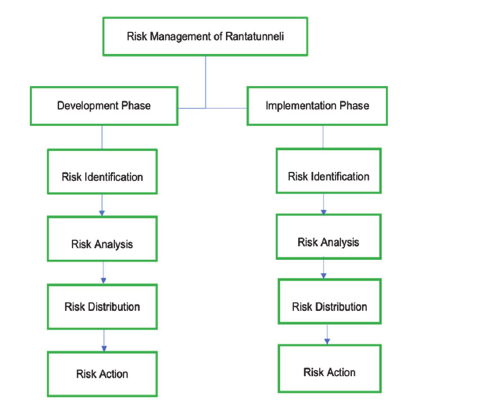
Fig. 1. RM processes of TRP and TTP